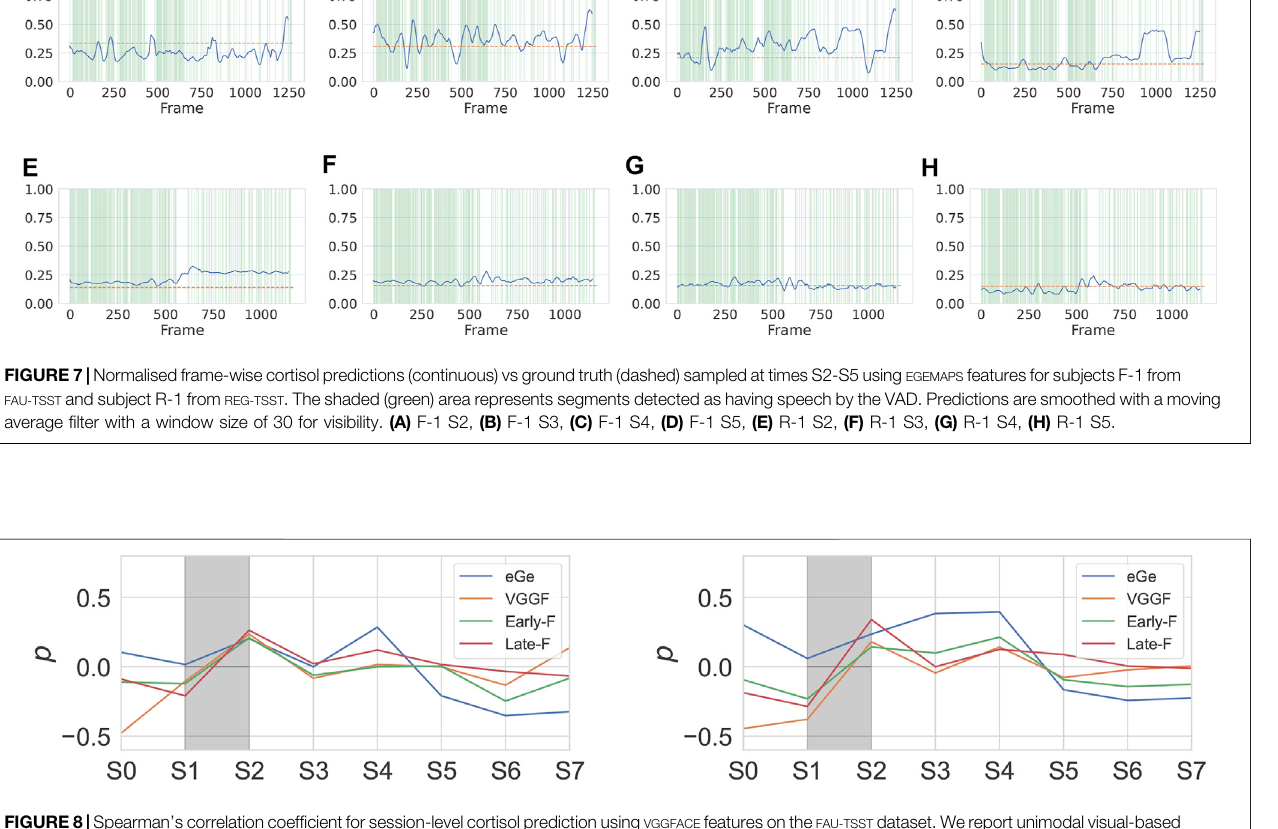
FIGURE8| Spearman ’ scorrelationcoef fi cientforsession-levelcortisolpredictionusing VGGFACE featuresonthe FAU-TSST dataset.Wereportunimodalvisual-based results as well as multimodal ones utilising early and late fusion with EGEMAPS features (A + V). We also replicate the EGEMAPS results from Table 2 for easier